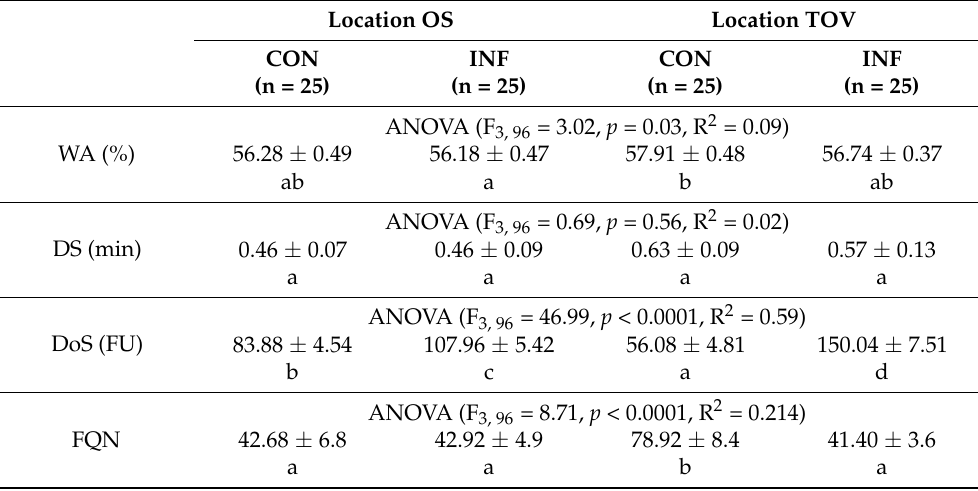
Table 2. Average values and standard error of rheological properties obtained using Farinograph for uninfected (control, CON) and FHB-infected (INF) flour samples of winter wheat cultivars grown at Osijek (OS) and Tovarnik (TOV) locations: water absorption—WA (%); dough stability—DS (min); degree of dough softening—DoS (FU); Fischer F statistics, p values, and regression coefficients (R 2 ) of two-way variance analysis model (ANOVA) for differences between locations, treatments, and their interaction. The letters are used to group mean values according to the analysis of the differences between categories, where values indicated by the same letter do not differ significantly (Tukey-HSD test at the significance level of p < 0.05). Location OS Location TOV CON INF CON (n = 25) (n = 25) (n = 25)